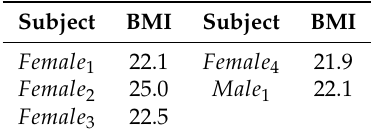
Table 5. Body mass index (BMI) of the